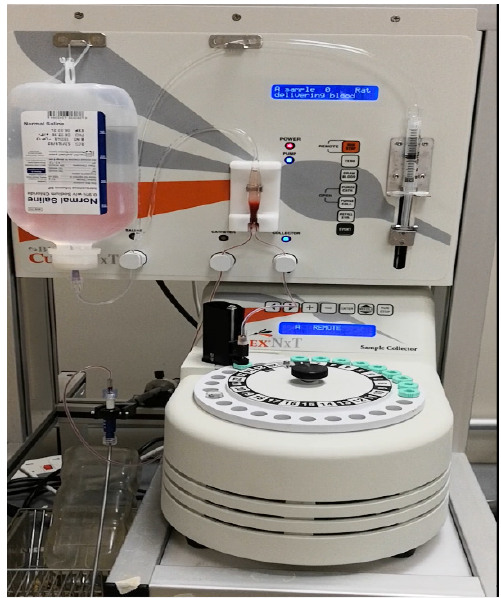
Figure 1. Automated blood sampling from freely mobile